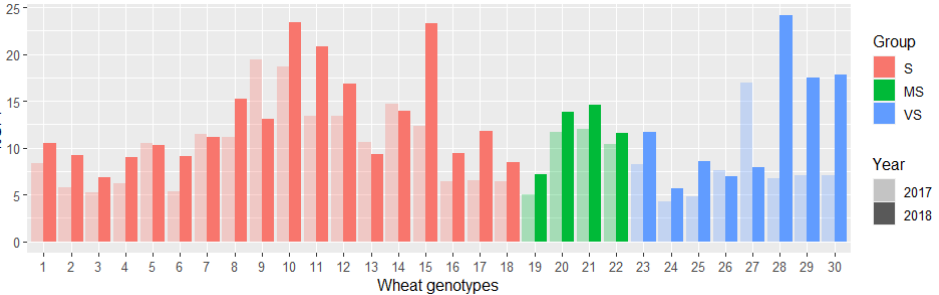
Figure 5. Unextractable polymeric protein (%UPP) in wheat dough samples in Groups S, MS, and VS of 30 spring wheat genotypes grown in cool (2017) and heat–drought (2018) years.